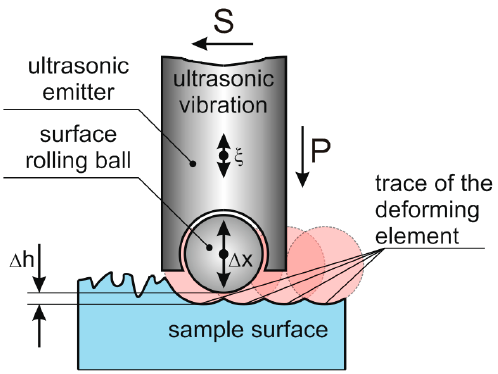
Figure 2. Scheme of treatment by a free deforming element (S—feed; P—static pressing force; ξ — amplitude of the emitter vibrations; Δ x—vibration amplitude of the deforming element ( Δ x ˃ ξ ); Δ h—dent depth of the sample surface).